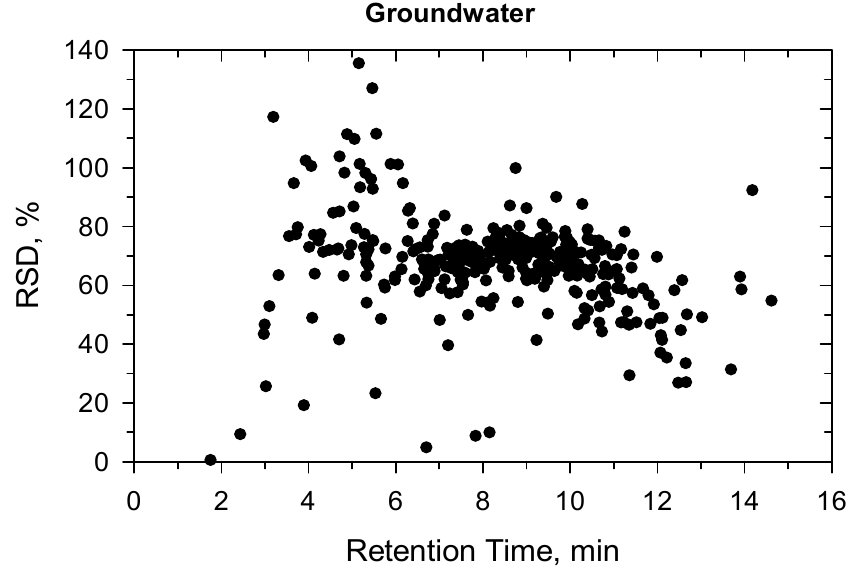
Figure 7. Recovery (%) versus retention time (min) at 10 ng/L in groundwater. Results were calculated without matrix compensation.